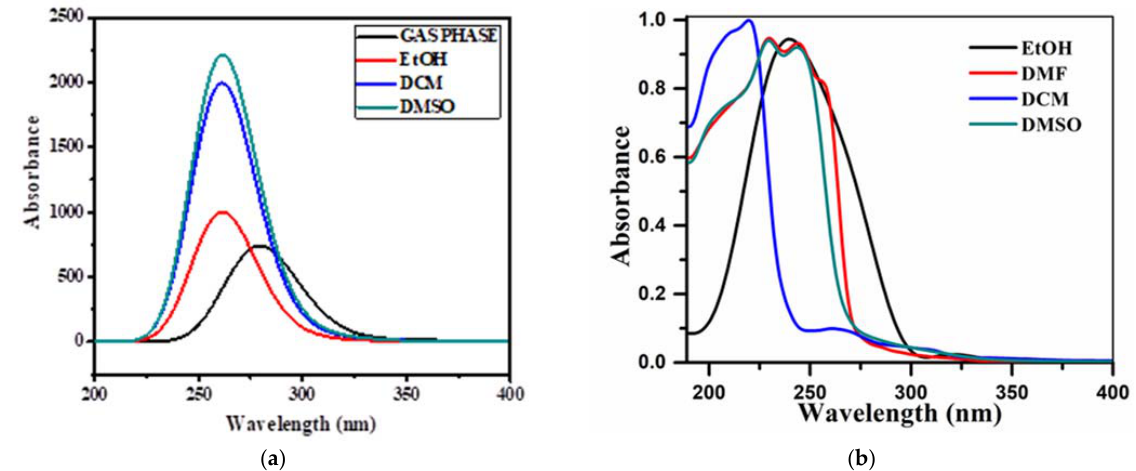
Figure 7. HOMO and LUMO with band gap energy.